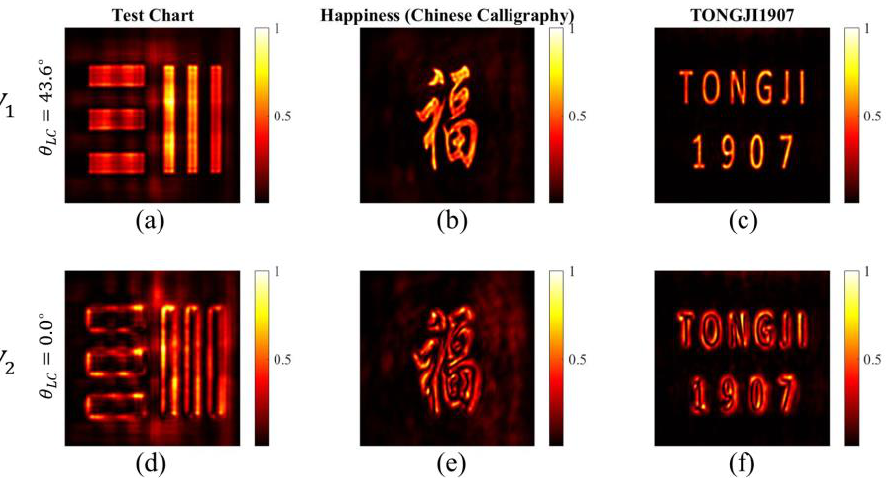
Figure 6. The simulated results for switching between thebright-field imaging and edge-enhanced imaging. ( a – c ) The bright-field images for different object with loading voltage V 1 . ( d – f ) The corresponding edge-enhanced images with loading voltage V 2 .